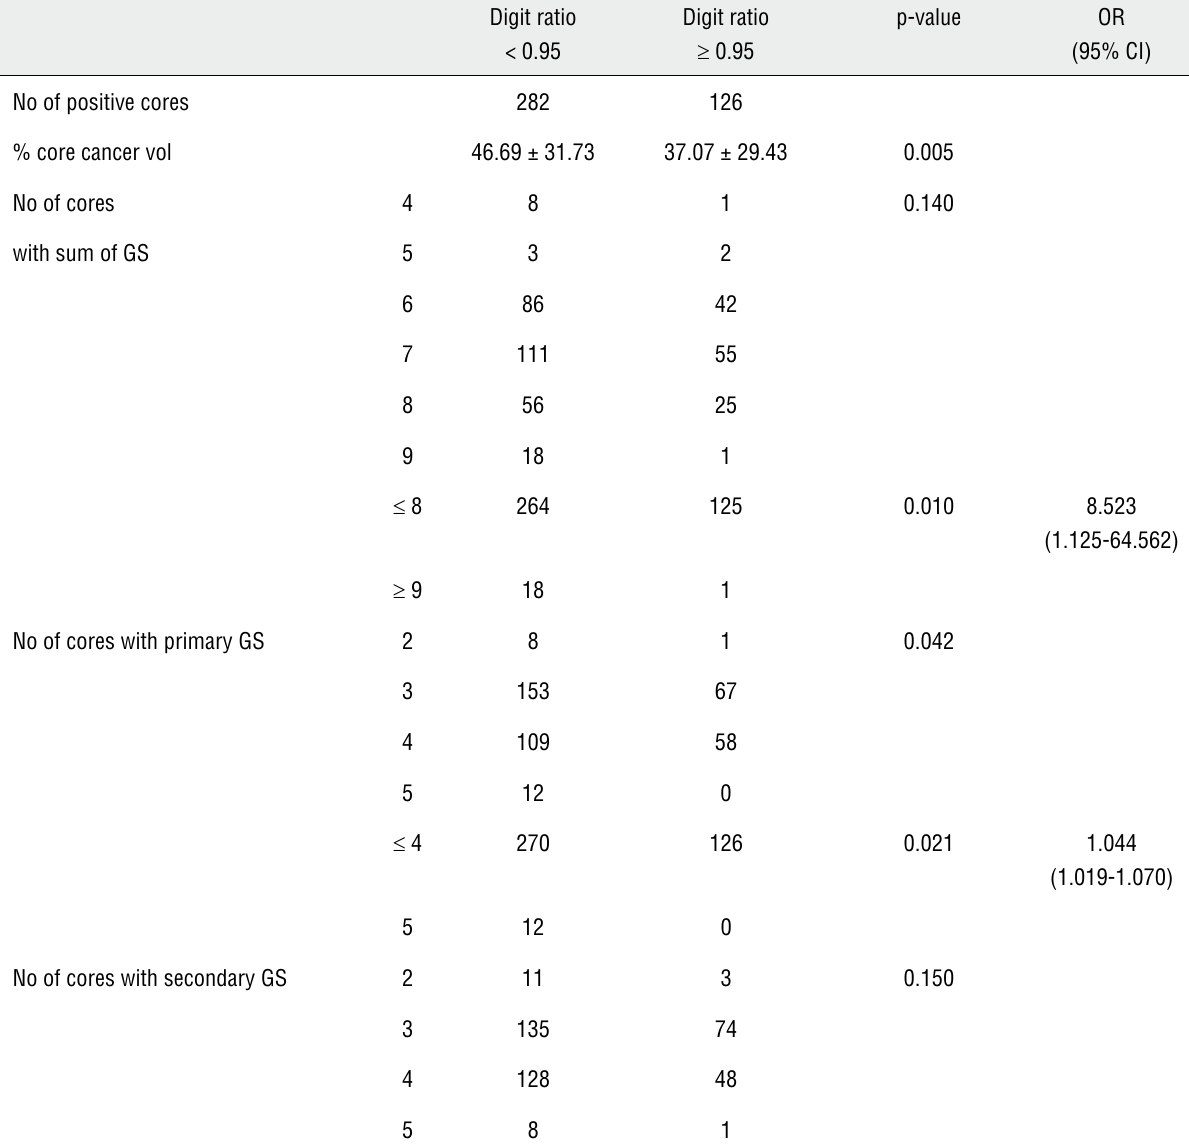
Table 5 - Comparison of the positive cores between the two studied